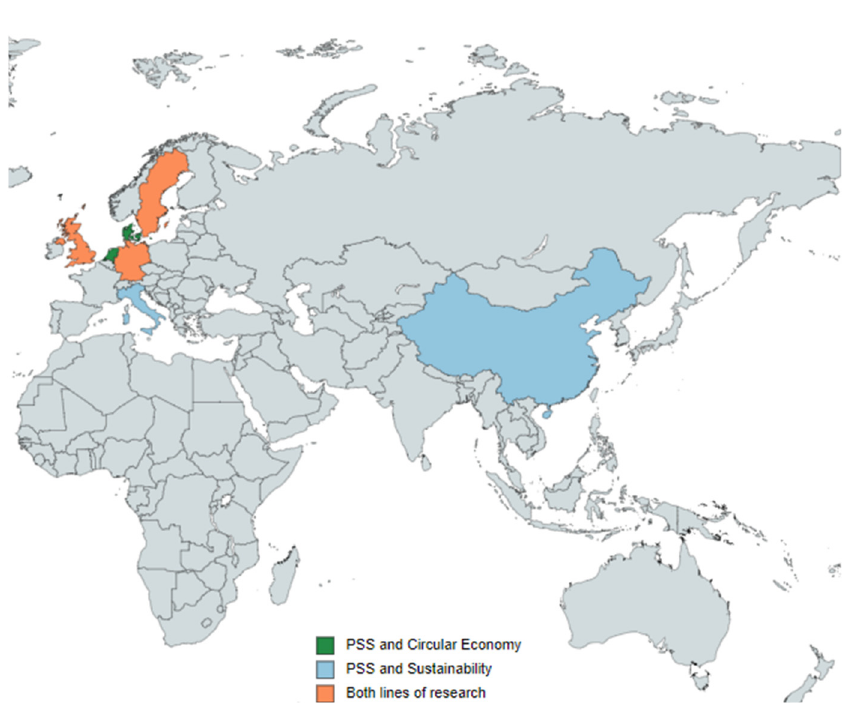
Table 14. Main keywords for sustainability and CE research.